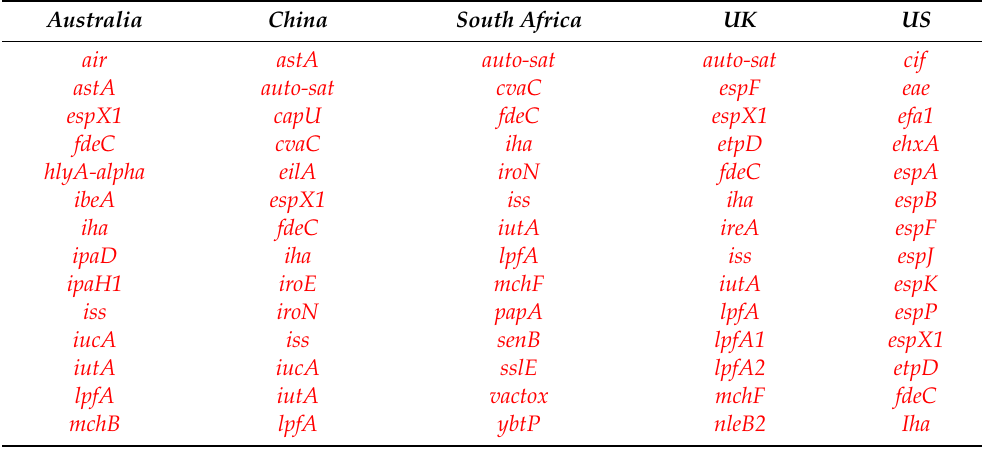
Table A1. Important virulence genes (red) and AMR genes (blue) identified in each country. Both types of genes were determined using independent hierarchical clustering